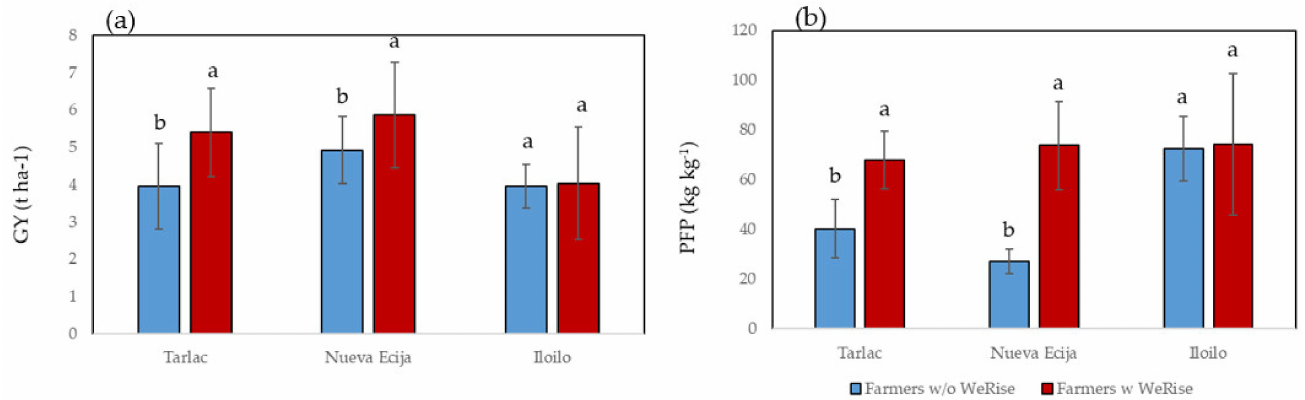
Figure 8. On-farm field validation of WeRise predictability for ( a ) grain yield (GY) and ( b ) partial factor productivity (PFP). Means with the same letter are not significantly different at 5% by Tukey’s